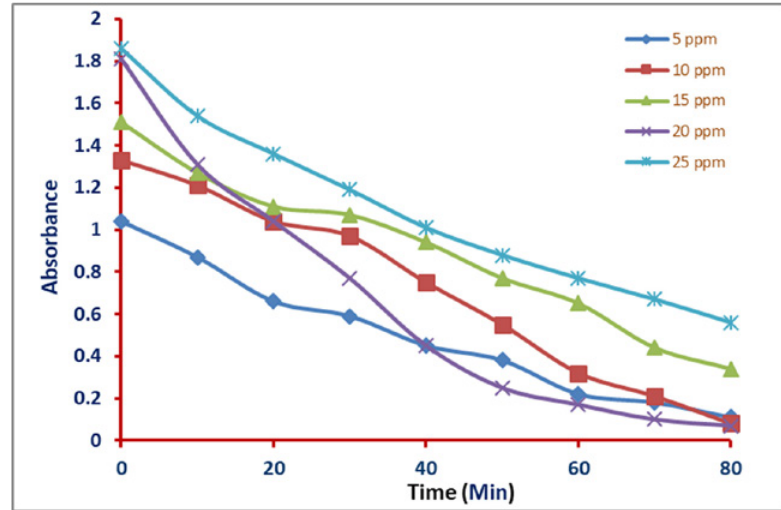
Fig. 6. Effect of initial dye concentration on the photocatalyst degradation of Nigrosine by using MgZrO